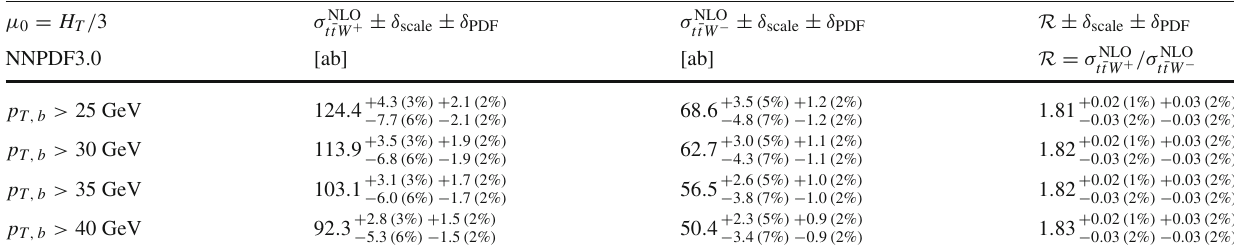
Table 2 As in Table 1 but for μ 0 = H T /